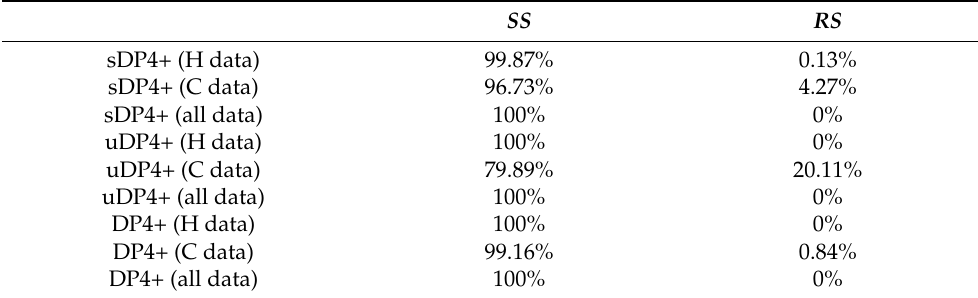
Table 3. DP4+ probabilities obtained for SS and RS isomers of 2 using the template from [21]; s and u refer to scaled and unscaled shifts.